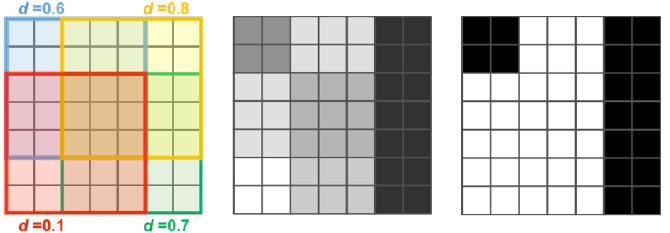
Figure 3. Simulated example of the map Θ I and corresponding binary mask of anomalies (cid:102) Ω I . Here, w t = h t = 5 and stride s = 3 and the variable d represents the value of the average visual similarity between the local patch and the most similar subregions of the dictionary W